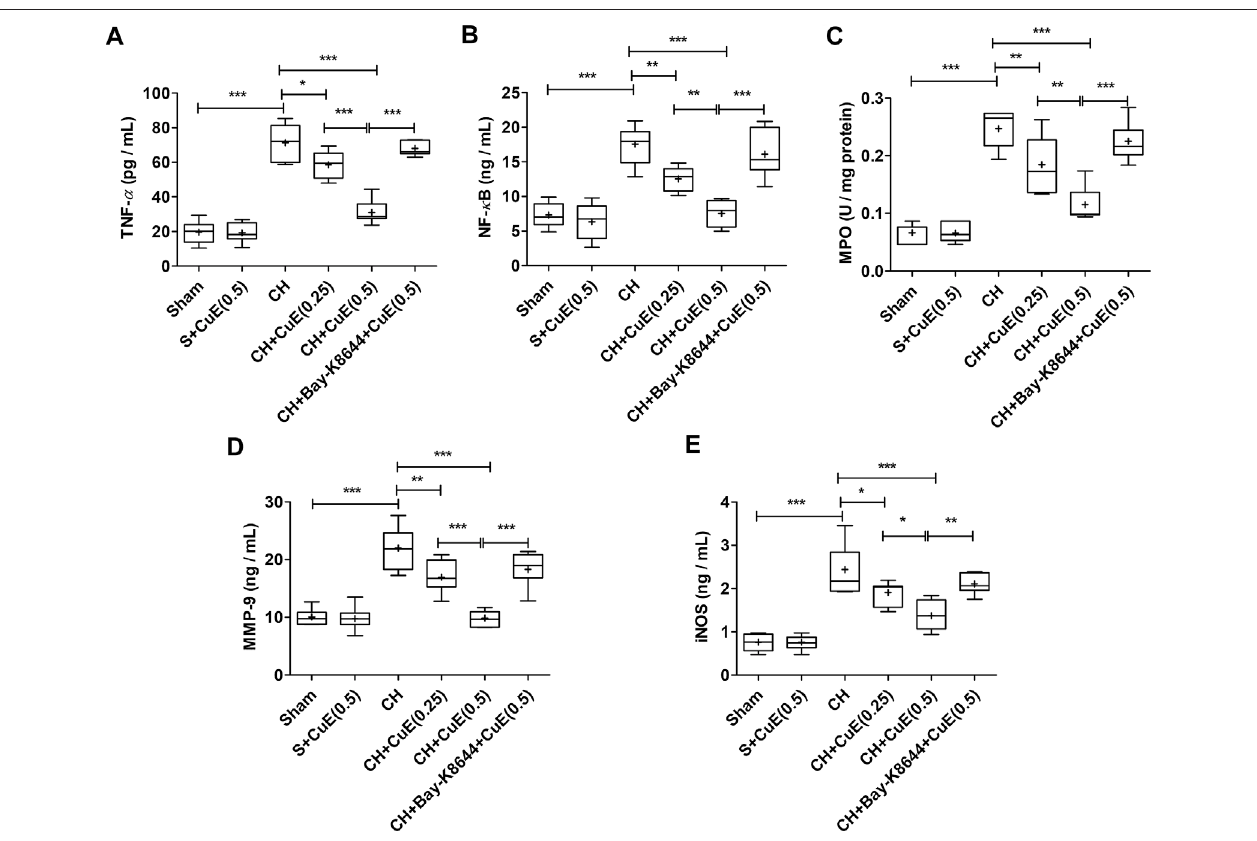
FIGURE4| CuEpost-treatment(0.25and0.5 mg/kg, p.o. )for28 daysdecreasedin fl ammatorycascadeagainstCH.CuEsigni fi cantlylowered (A) TNF- α , (B) NF- κ B level, (C) MPO activity, (D) MMP-9, and (E) iNOS in the brain of rats exposed to CH on day 1. Bay-K8644 attenuated anti-in fl ammatory activity of CuE. Box and whisker plots (Tukey) show mean (+), median (bold horizontal line), quartiles (box), and total range (whisker) ( n (cid:1) 7). * ( p < .05), ** ( p < .01), *** ( p < .001)